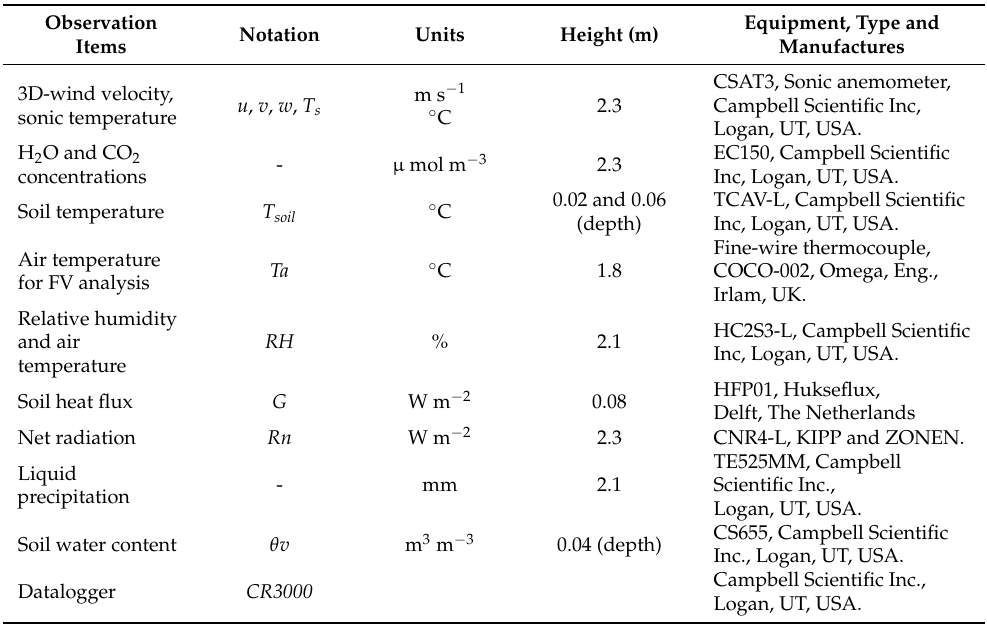
Table 2. Information of the instruments used during the experiment, including manufactures, installation height, notations and measuring